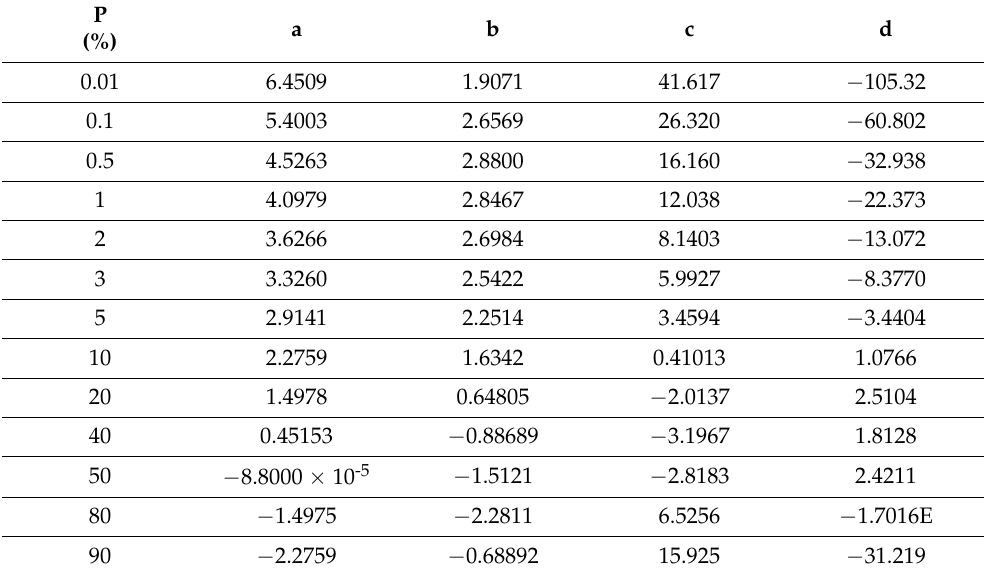
Table A7. The frequency factor for estimation with L-moments for